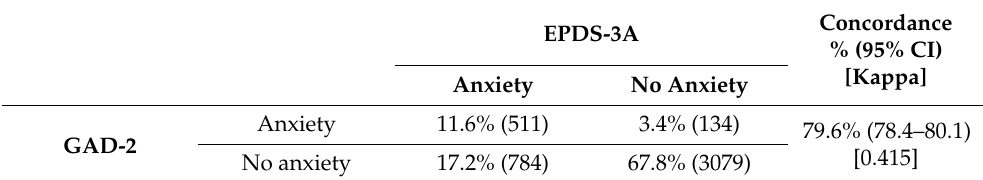
Table 4. Concordance and kappa values for GAD-2 and EPDS-3A (n = 4508).